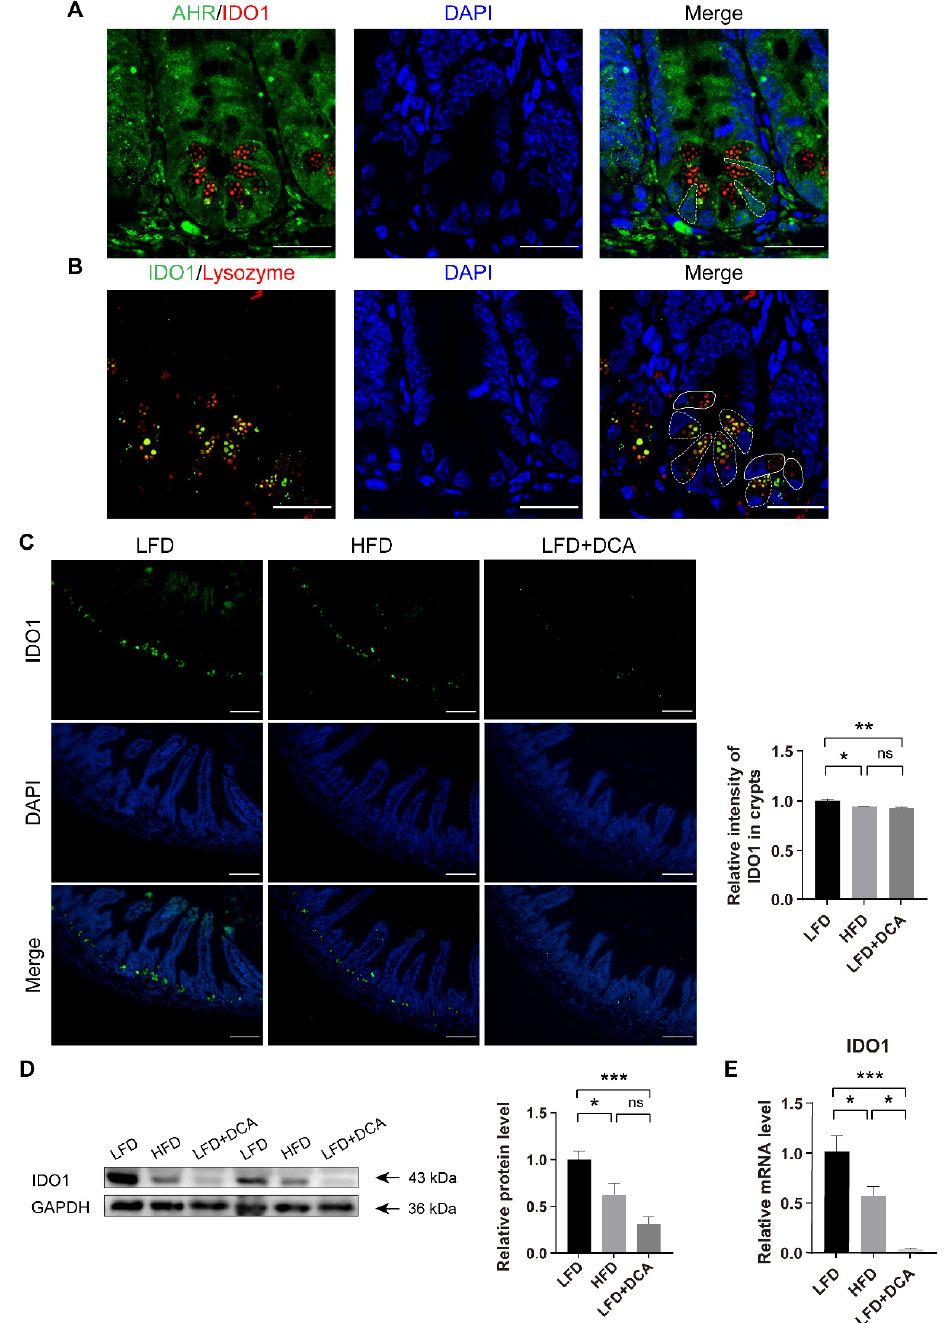
Figure 6. DCA downregulates IDO1 in PCs in intestinal crypts. ( A ) Immunofluorescence staining of DAPI (blue), lysozyme (red) and IDO1 (green) showed that IDO1 was expressed in low-AHR fluorescence intensity areas in ileal crypts. The white dashed line indicates the location of the ISCs; scale bars, 25 µ m. ( B ) Immunofluorescence staining of DAPI (blue), lysozyme (red) and IDO1 (green) showed that IDO1 was expressed in PCs. The white dashed line indicates IDO1 + PCs, and the white line indicates IDO1 − PCs; scale bars, 25 µ m. ( C ) Representative immunofluorescence images of IDO1 and analysis of fluorescence intensity in different groups (n = 5); scale bars, 100 µ m. ( D ) Relative protein levels of IDO1 in ileal tissue and analysis in different groups (n = 7). ( E ) Relative mRNA levels of IDO1 in ileal tissue (n = 5) in different groups. Data are shown as the mean ± SEM. PCs, Panteh cells; AHR, aryl hydrocarbon receptor; IDO1, indoleamine 2,3-dioxygenase 1; LFD, low-fat diet; HFD, high-fat diet; DCA, deoxycholic acid. * p < 0.05; ** p < 0.01; *** p < 0.001; ns, no significant